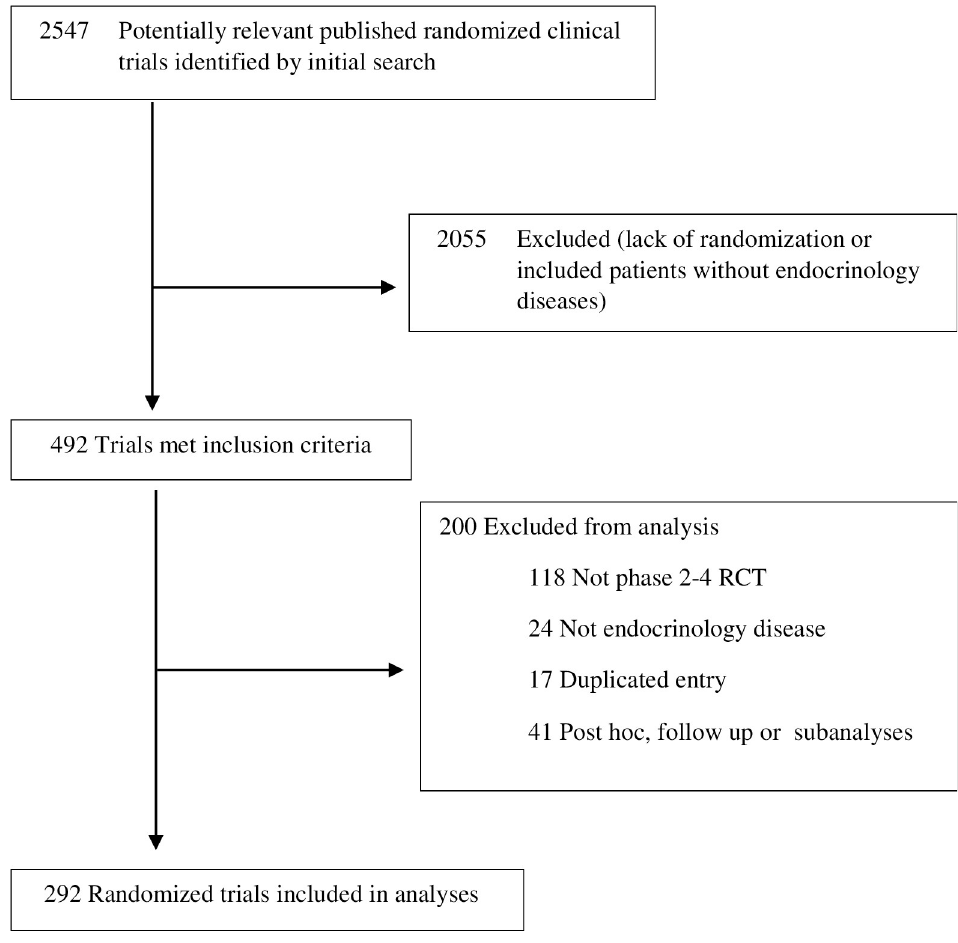
Fig 1. Flow diagram of included